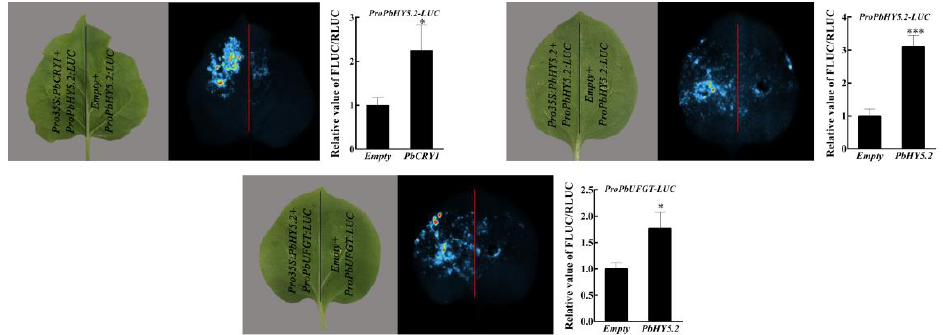
Figure 6. Detection and live imaging of transcriptional activation activity: A representative image of a Nicotiana benthamiana leaf 3 days after infiltration is shown. Quantitative analysis on the right corresponds to live imaging. The experiments were independently repeated three times and yielded similar results. Data are the mean ± SD from three replicates ( n = 3). Asterisks indicate a significant difference (two-tailed Student’s t -test: * p < 0.05, *** p < 0.001).